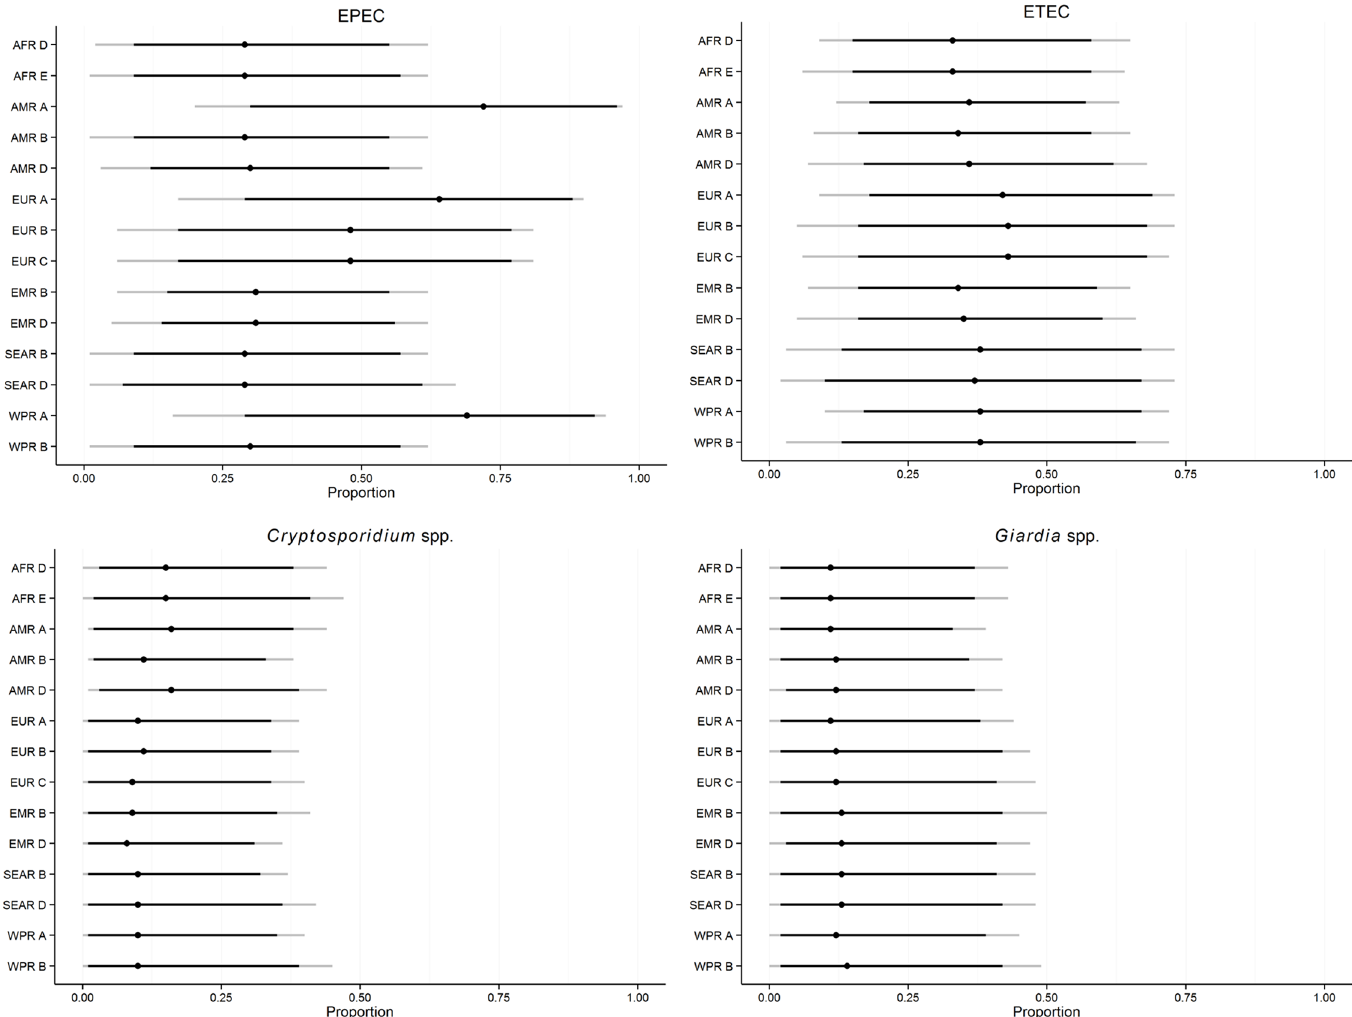
Fig 4. Subregional estimates of the proportion of foodborne illnesses caused by enteropathogenic E . (EPEC), enterotoxigenic E . coli (ETEC), Cryptosporidium spp. and Giardia spp. Indicated on the line plot are the 2.5 th , 5 th , 50 th , 95 th and 97,5 th